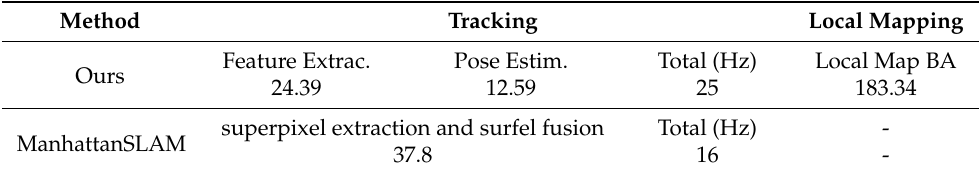
Table 5. Mean execution time (TUM RGB-D benchmark).